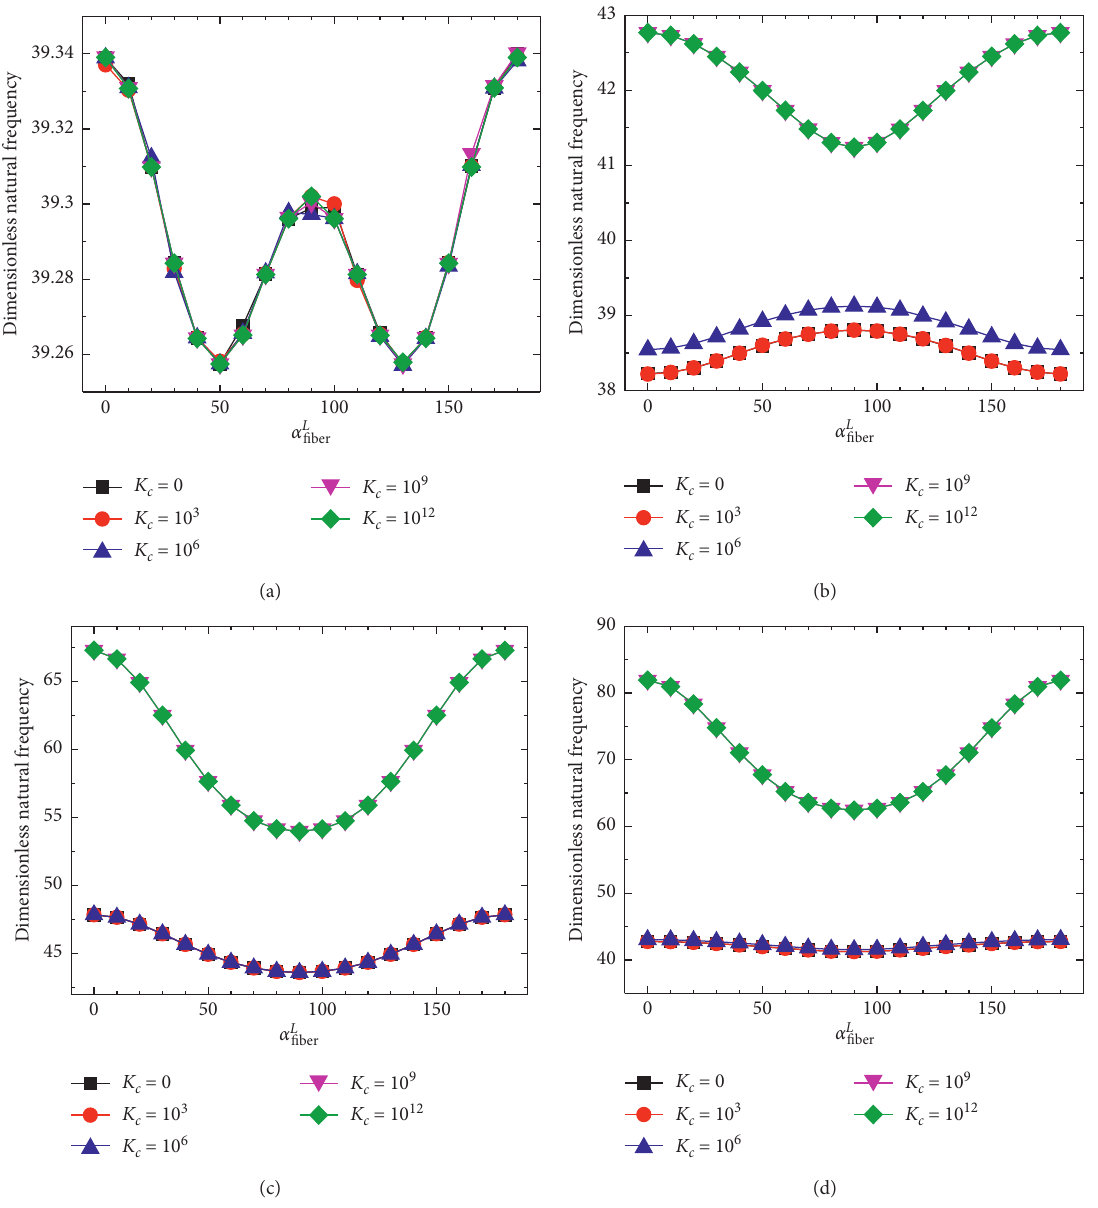
Figure 6: Variation of dimensionless natural frequency versus fiber angle for an LCDPS with different conditions. (a) CCCC-CCCC, 1st mode; (b) SSSS-SSSS, 2nd mode; (c) CCCC-CCCC, 3rd mode; (d) SSSS-SSSS, 4th